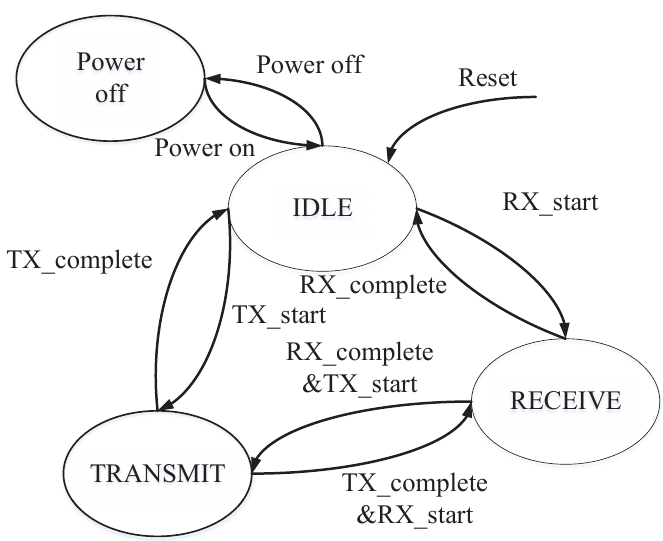
Figure 12. Signal data exchange control state machine.